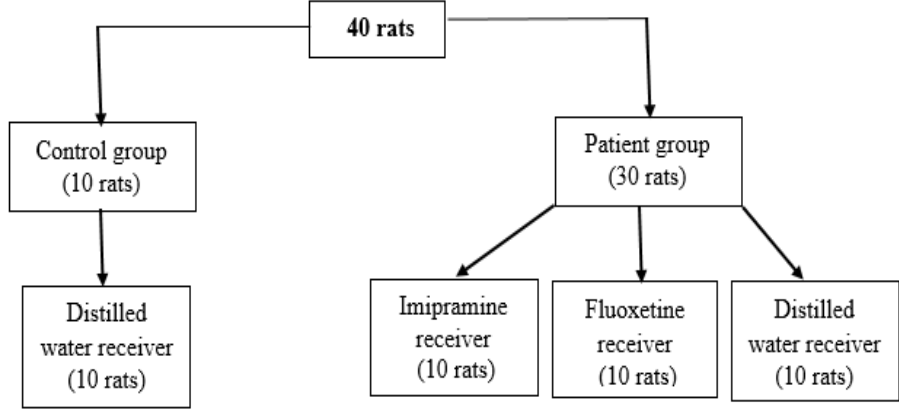
Fig. 3. The procedure of dividing the control and patient